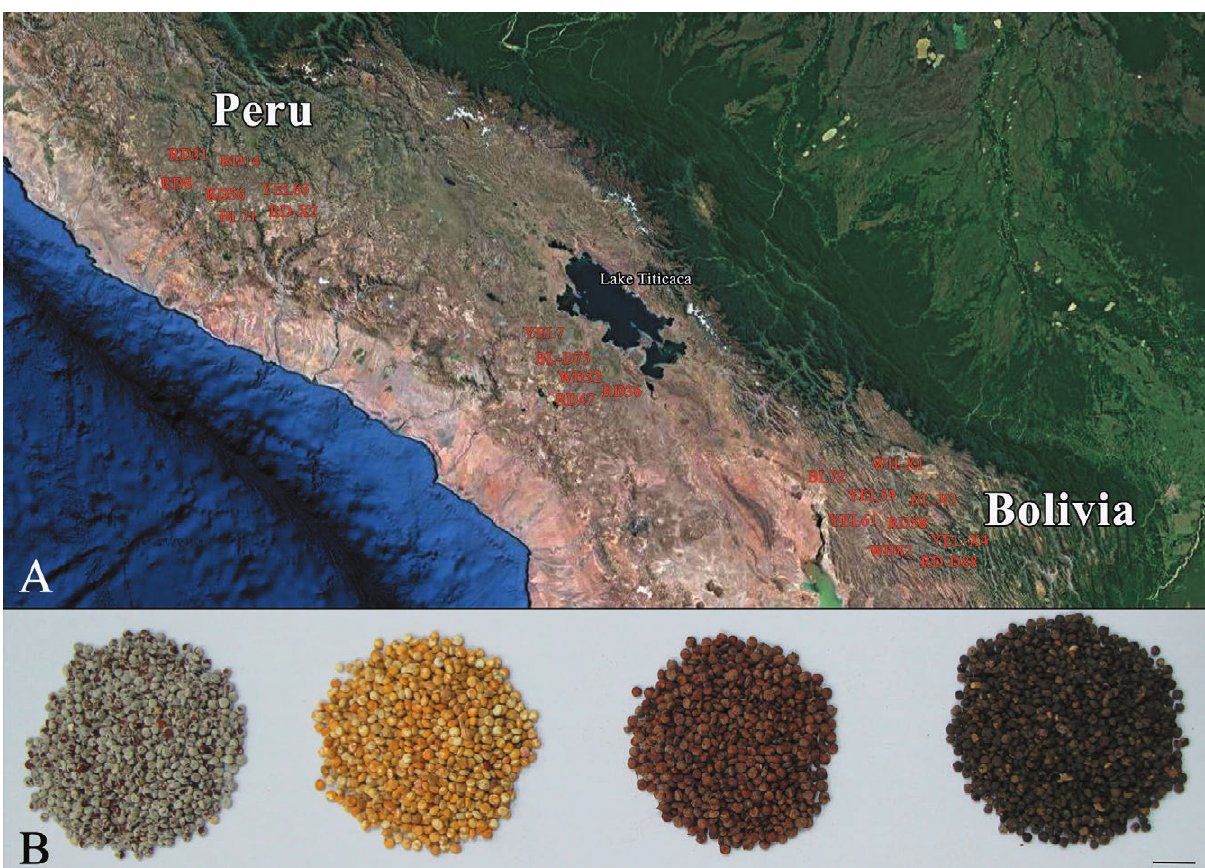
Figure 1. (A) Map showing the collection area of the studied cultivars (B) Photographs of seeds showing morphological variation (bar=1